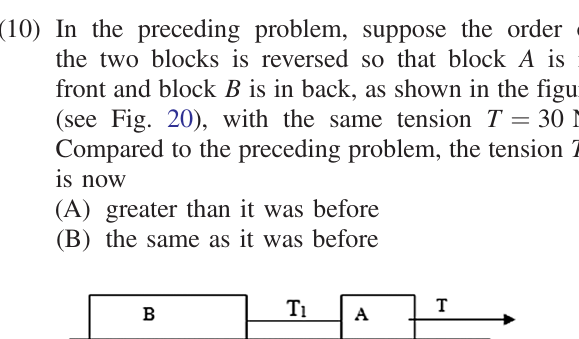
FIG. 20. Figure for Newton ’ s Laws post-test Problem